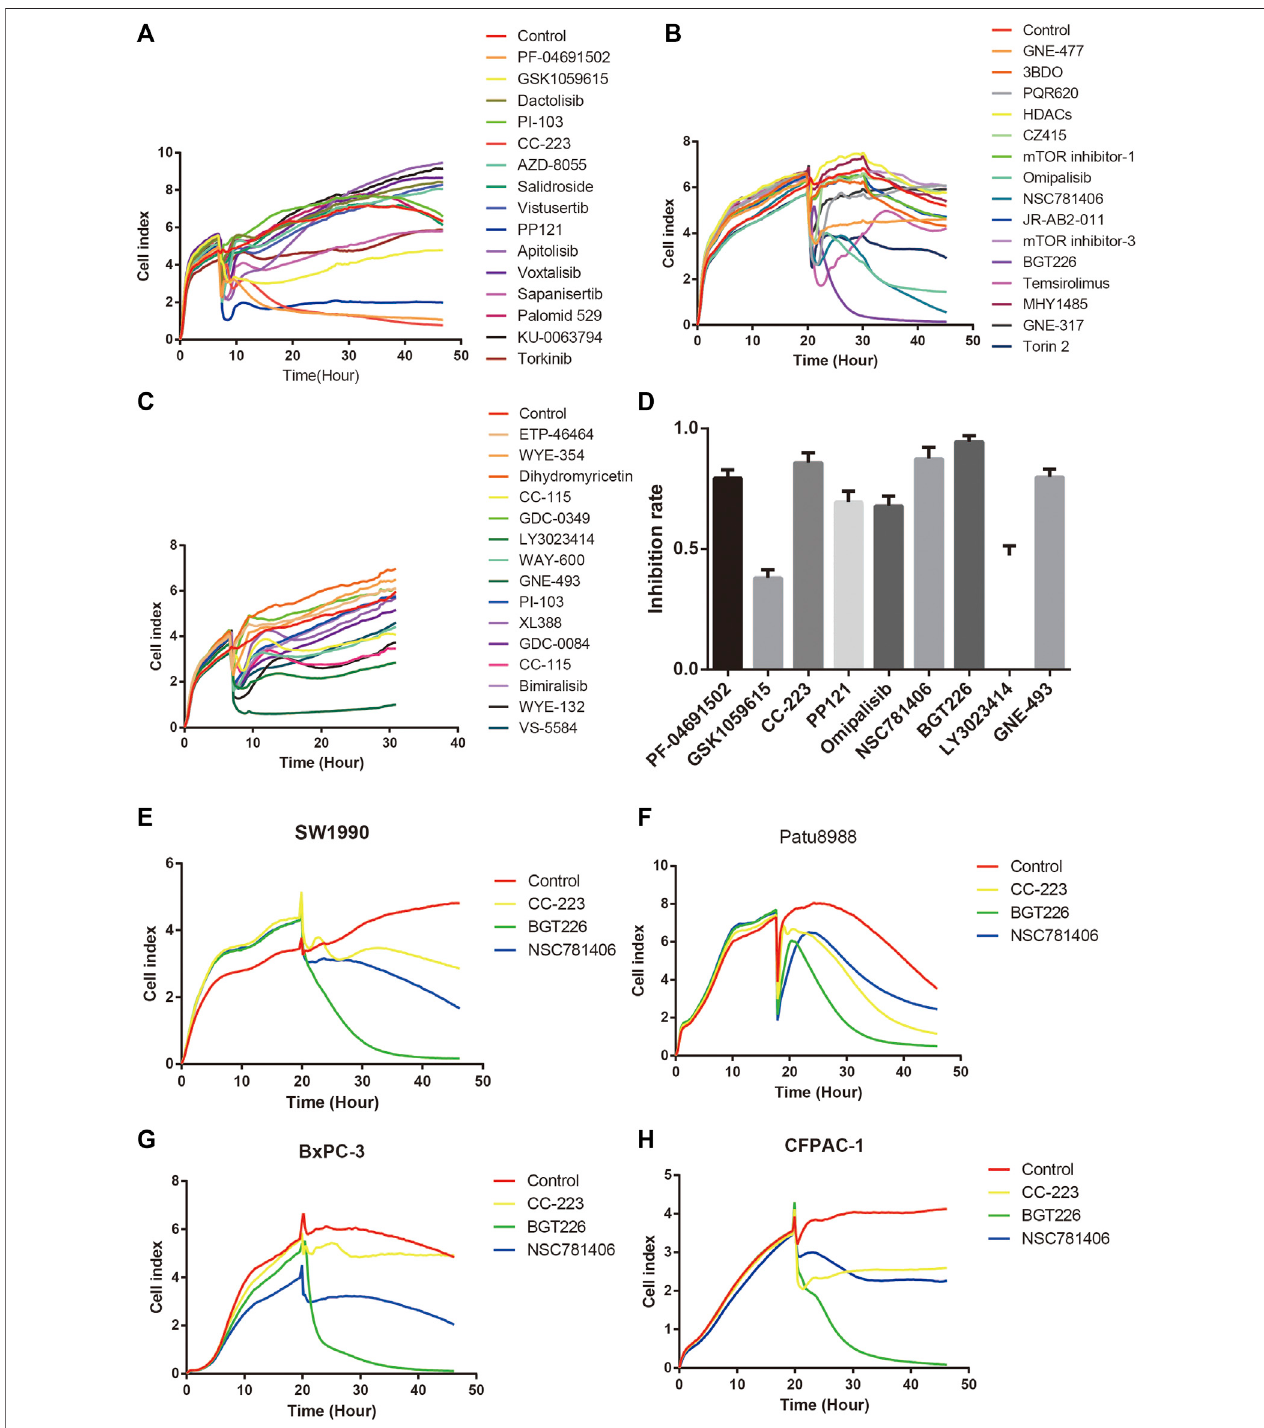
FIGURE 2 | Effects of mTOR inhibitors on the proliferation of pancreatic cancer cells. (A) RTCA assay. Cells were treated with PF-04691502, GSK1059615, Dactolisib, PI-103, CC-223, AZD-8055, Salidroside, Vistusertib,PP121, Apitolisib, Voxtalisib, Sapanisertib, Palomid529,KU-0063794, and Torkinib(20 μ M). (B) RTCA assay. Cells were treated with GNE-477, 3BDO, PQR620, HDACs, CZ415, mTOR inhibitor-1, Omipalisib, NSC781406, JR-AB2-011, mTOR inhibitor-3, BGT226, Temsirolimus, MHY1485, GNE-317, and Torin 2 (20 μ M). (C) RTCA assay. Cells were treated with ETP-46464, WYE-354, Dihydromyricetin, CC-115 (hydrochloride), GDC-0349, LY3023414, WAY-600, GNE-493, PI-103 (hydrochloride),XL388, GDC-0084, CC-115, Bimiralisib,WYE-132, and VS-5584 (20 μ M). (D) A statistical bar chart of RTCA results ofmTOR inhibitors. (E) RTCA assay. SW1990 cells were treated with CC-223, NSC781406, and BGT226 (20 μ M). (F) RTCA assay. Patu8988 cells were treated with CC-223, NSC781406, and BGT226 (20 μ M). (G) RTCA assay. BxPC-3 cells were treated with CC-223, NSC781406, and BGT226 (20 μ M). (H) RTCA assay. CFPAC-1 cells were treated with CC-223, NSC781406, and BGT226 (20 μ M).